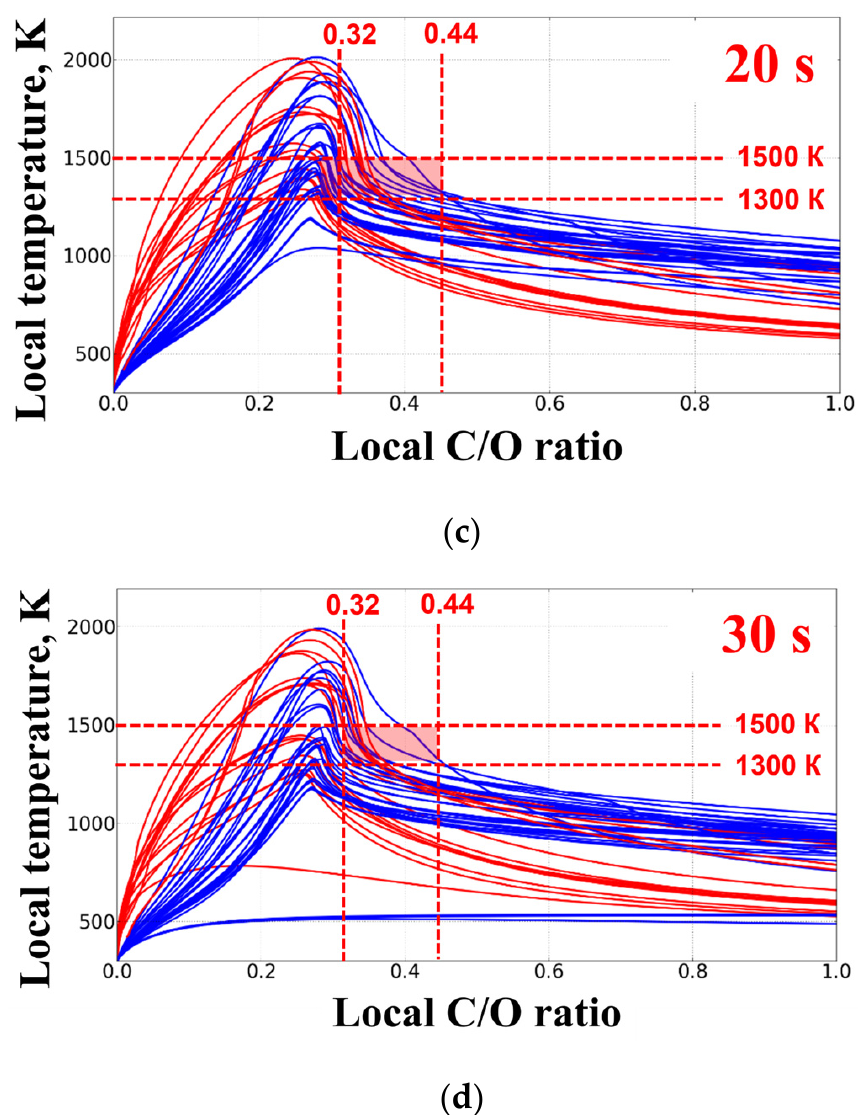
Figure 12. Calculated dependences of temperature on the local C/O atomic ratio in normal (blue curves) and inverse (red curves) flames in 2 ( a ), 10 ( b ), 20 ( c ), and 30 s ( d ) after ignition. The regions colored with red fill correspond to the parametric domains of soot formation.